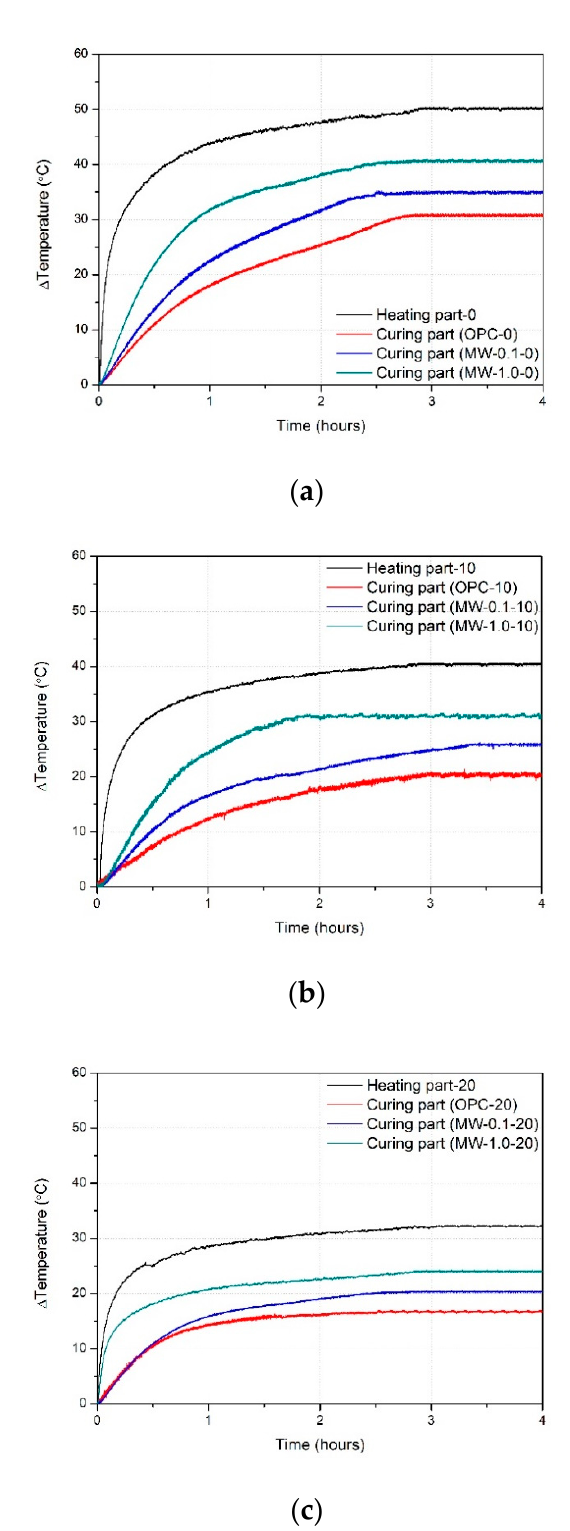
Figure 7. Temperature variation of the specimens with heat curing in the insulation box at a chamber temperature of ( a ) 0 °C, ( b ) − 10 °C, and ( c ) − 20